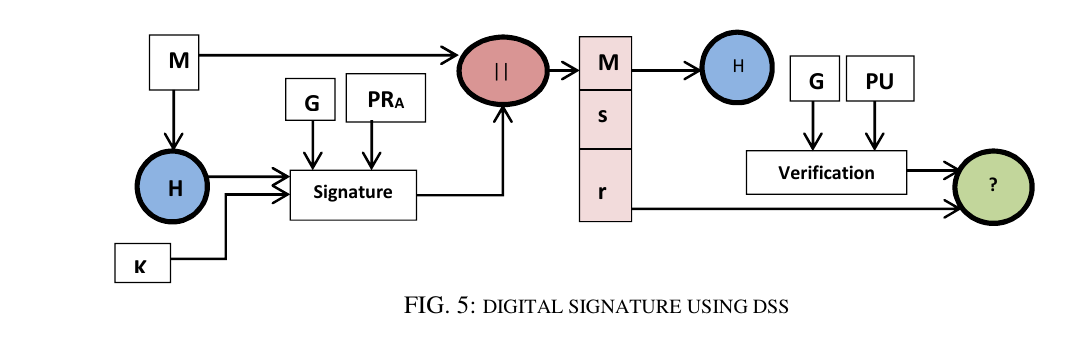
FIG. 5: DIGITAL SIGNATURE USING